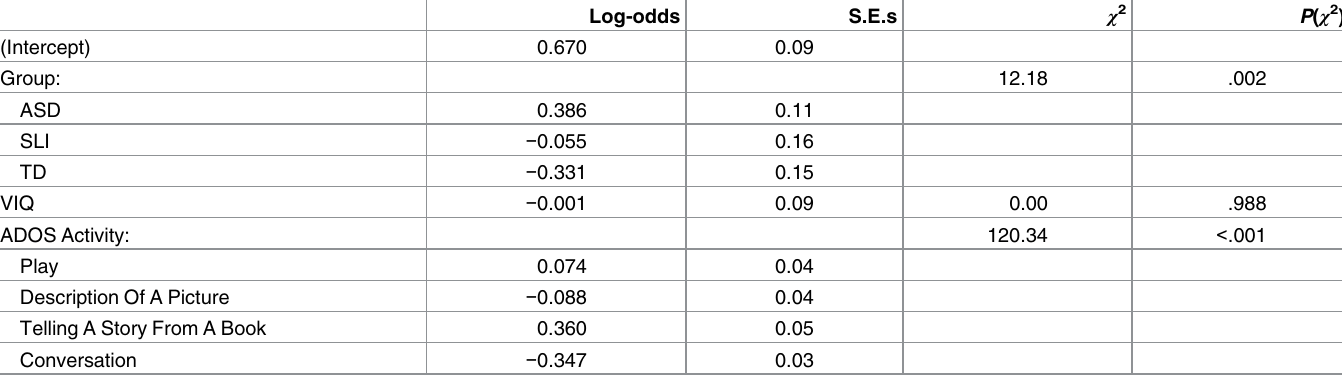
Table 4. Results for regression on content mazesversus